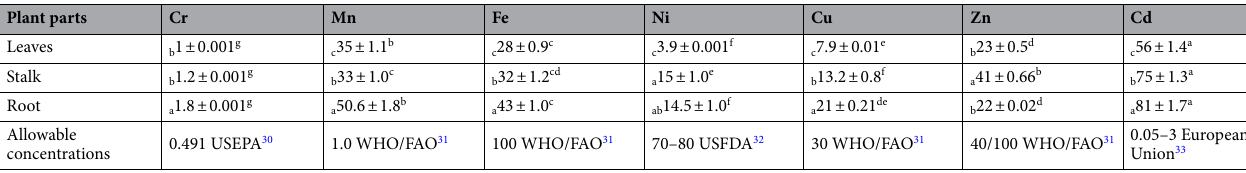
Table 5. Heavy metal concentrations in Eichhornia crassipes (mg/kg.dw). All values are presented as mean ± SEM (n = 8). Superscripts indicates significant differences along the row and subscripts along the column. Significance was tested at p <